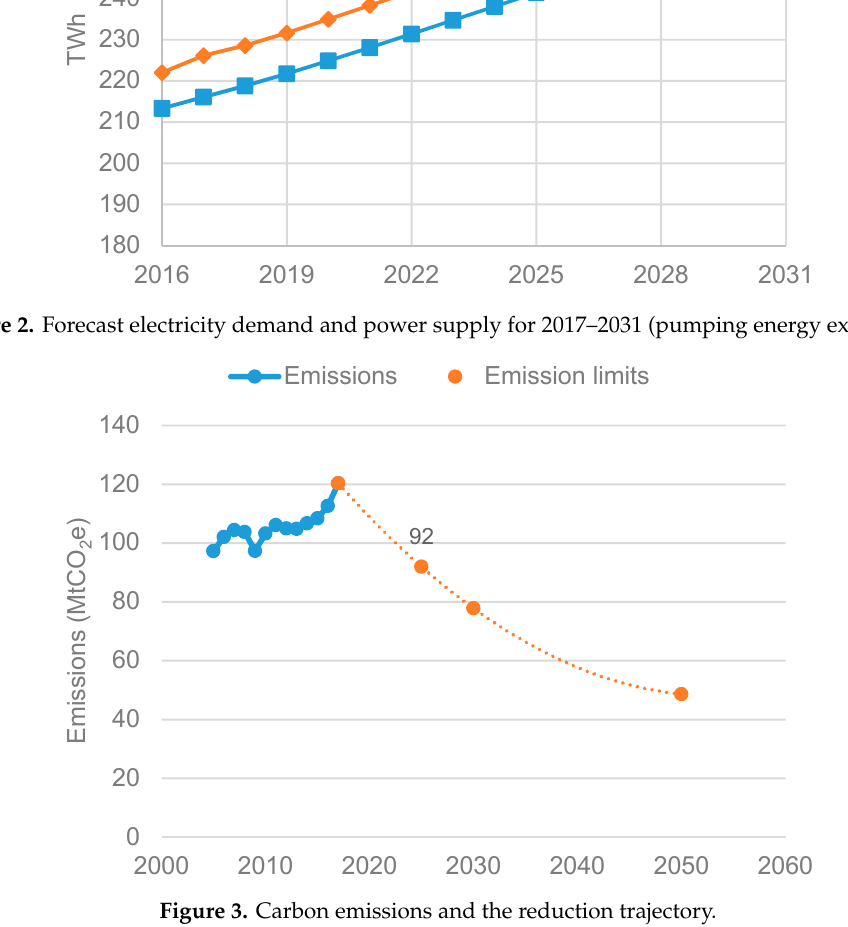
Table 2. Projected 2025 baseline generation capacity. Source